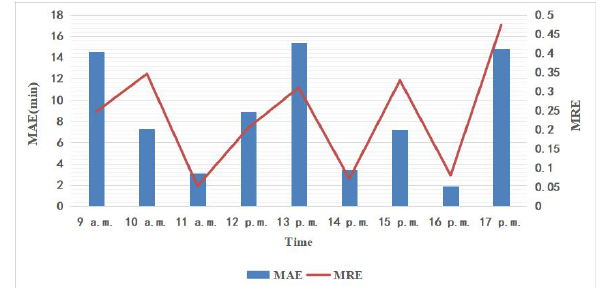
Figure 15. Travel time estimation of taxi ID 1277 on Friday